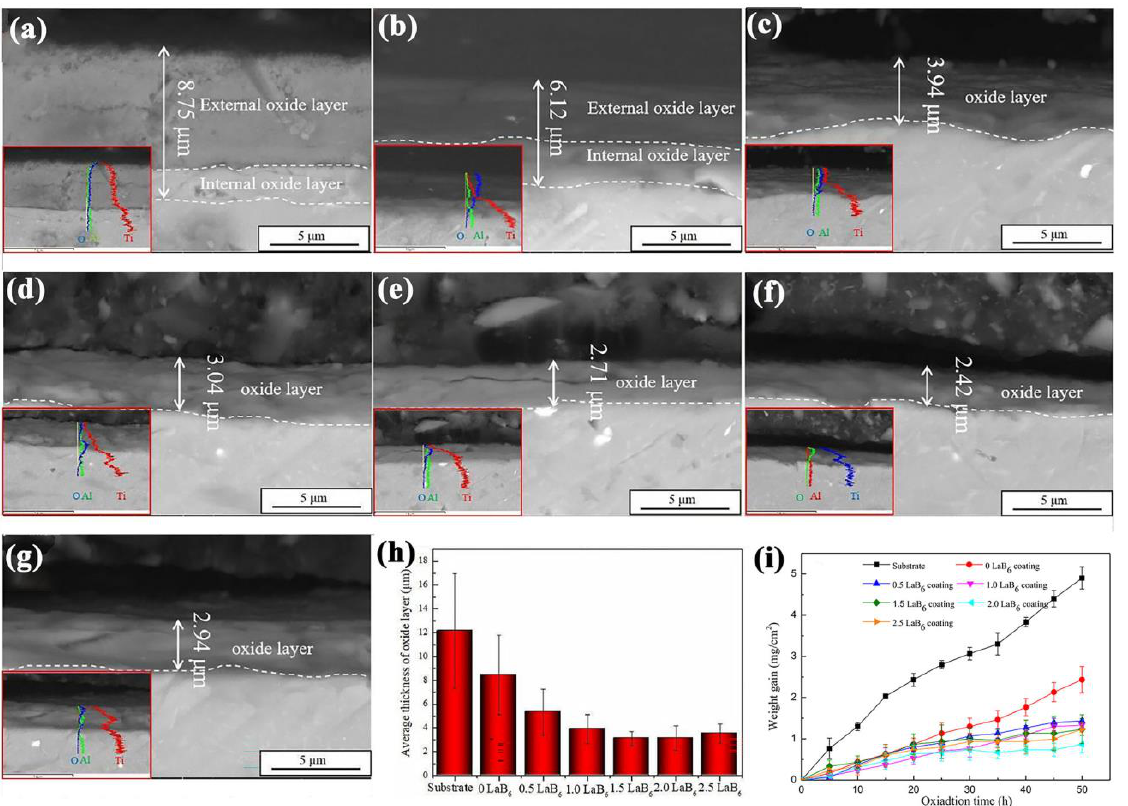
Figure 12. Cross-section morphology of oxide layers obtained at 600 °C for 50 h for the Ti-6Al-4V substrate and (TiC + TiBx)/Ti coatings with different amounts of LaB 6 addition and corresponding weight gain curves with time: ( a ) Ti-6Al-4V substrate, ( b ) 0 wt% LaB 6 -doped coating, ( c ) 0.5 wt% LaB 6 -doped coating, ( d ) 1.0 wt% LaB 6 -doped coating, ( e ) 1.5 wt% LaB 6 -doped coating, ( f ) 2.0 wt% LaB 6 -doped coating, ( g ) 2.5 wt% LaB 6 -doped coating, ( h ) average thickness, ( i ) oxidation weight